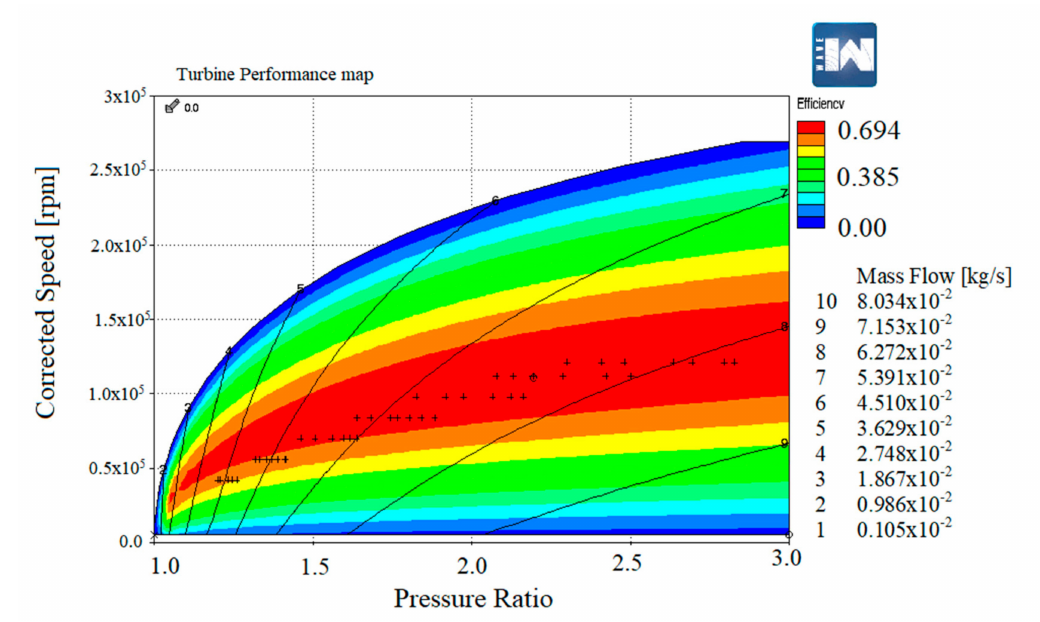
Figure 6. Turbine Ricardo WAVE